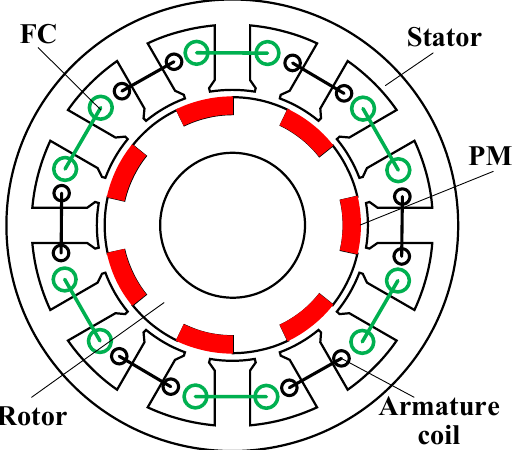
Figure 7. Configuration of the mixed ‐ excited HE machine with solely radial field [37].